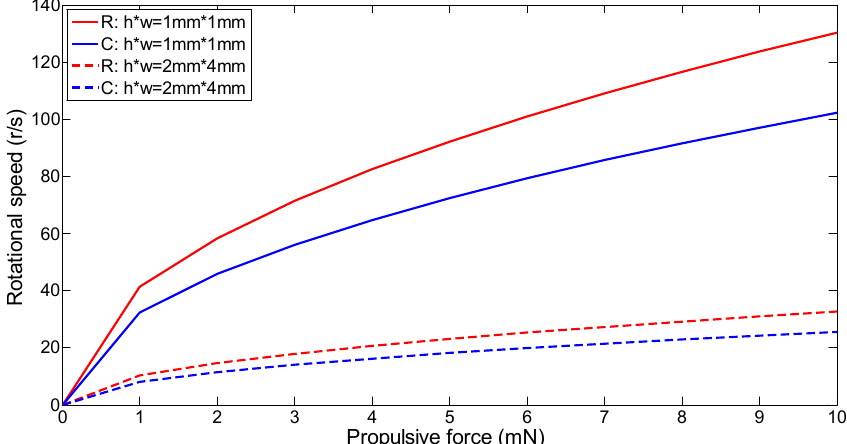
Figure 3. Simulation results with different parameters, R means rectangular screw groove, C means cylindrical screw groove.